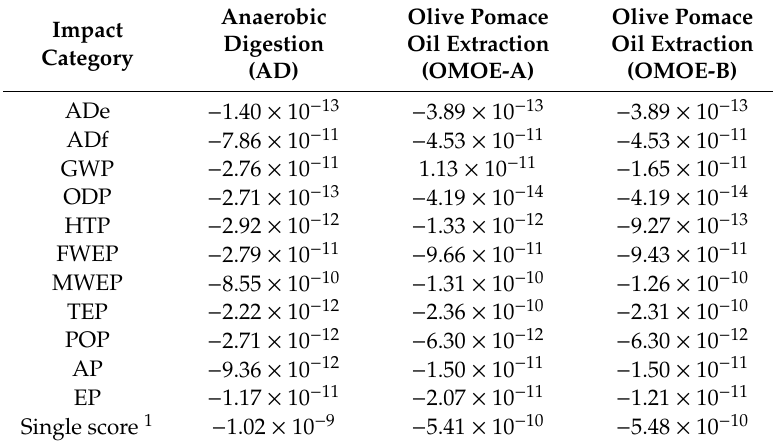
Table 4. Normalized environmental impacts and single scores per kg of olive mill solid waste, where ADe, abiotic depletion potential of elements; ADf, abiotic depletion potential of fossil fuel resources; GWP, global warming potential; ODP, ozone depletion potential; HTP, human toxicity potential; FWEP, freshwater aquatic ecotoxicity potential; MWEP, marine aquatic ecotoxicity potential; TEP, terrestrial ecotoxicity potential; POP, photochemical oxidants creation potential; AP, acidification potential; and EP, eutrophication potential (EP). Olive Pomace Olive Pomace Anaerobic Impact Oil Extraction Oil Extraction Digestion Category (OMOE-B) (OMOE-A) (AD)